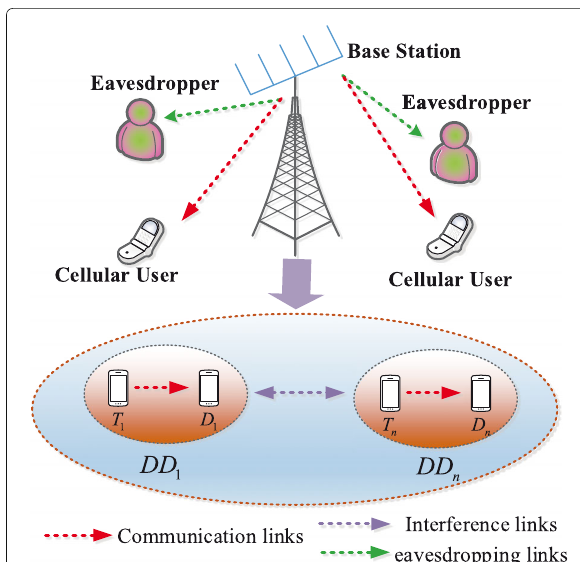
Fig. 1 System model. Figure 1 depicts the cellular downlink between the base station and the cellular user in which a set of malicious eavesdroppers attempt to intercept the confidential message of the cellular link in a passive